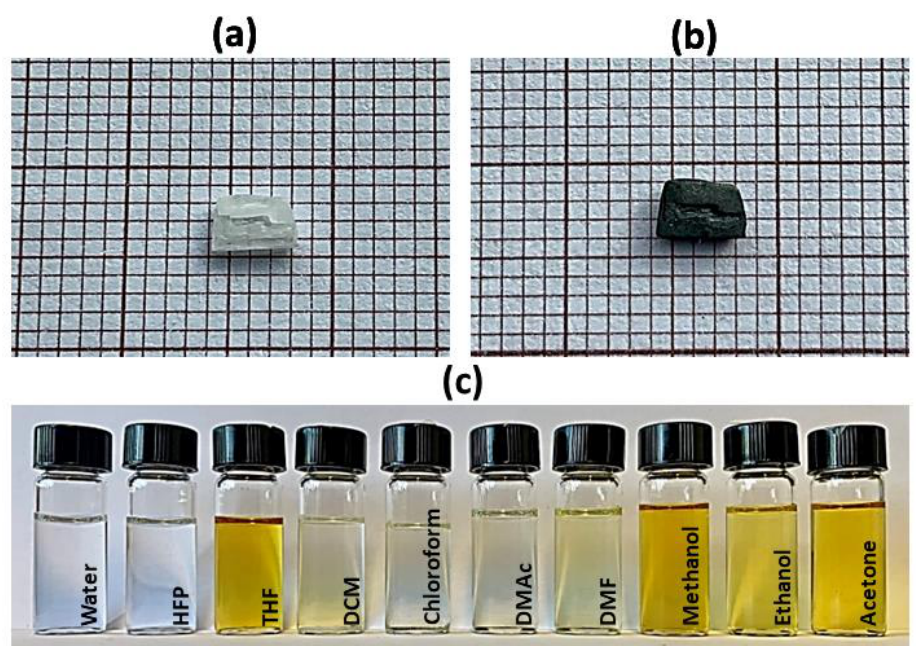
Figure 2. MDABCO-NH 4 I 3 perovskite crystal, after several hours ( a ) and after 2 weeks ( b ) of exposure in the open air at room temperature. Perovskite solutions in different solvents ( c ), from left to right: water, hexafluoroisopropanol (HFP), tetrahydrofuran (THF), dichloromethane (DCM), chloroform, dimethylacetamide (DMAc), dimethylformamide (DMF), methanol, ethanol, and acetone.